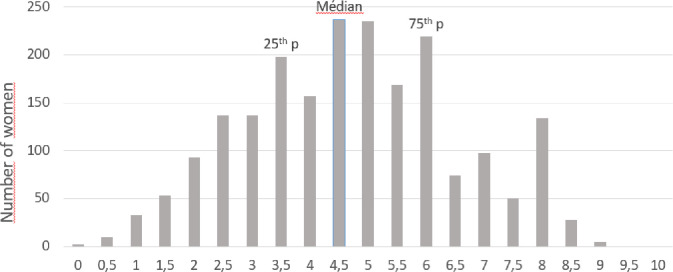
Distribution of Knowledge scores.